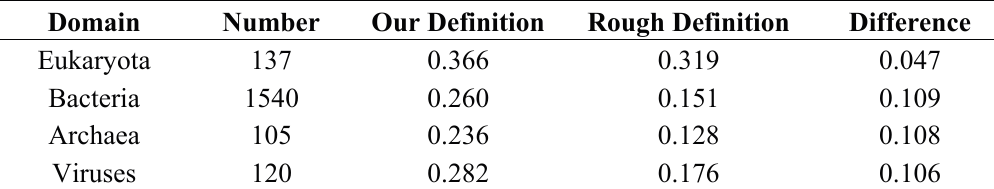
Table 4. Average contents of disorder for 4 domains of